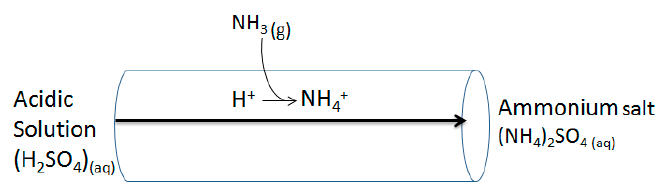
Figure 1. Schematic demonstrating the diffusion of ammonia gas (NH 3 ) across the gas-permeable membrane and the reaction with the hydrogen ion (H + ) donated from the acid to form liquid ammonium (NH 4 ) which is captured.